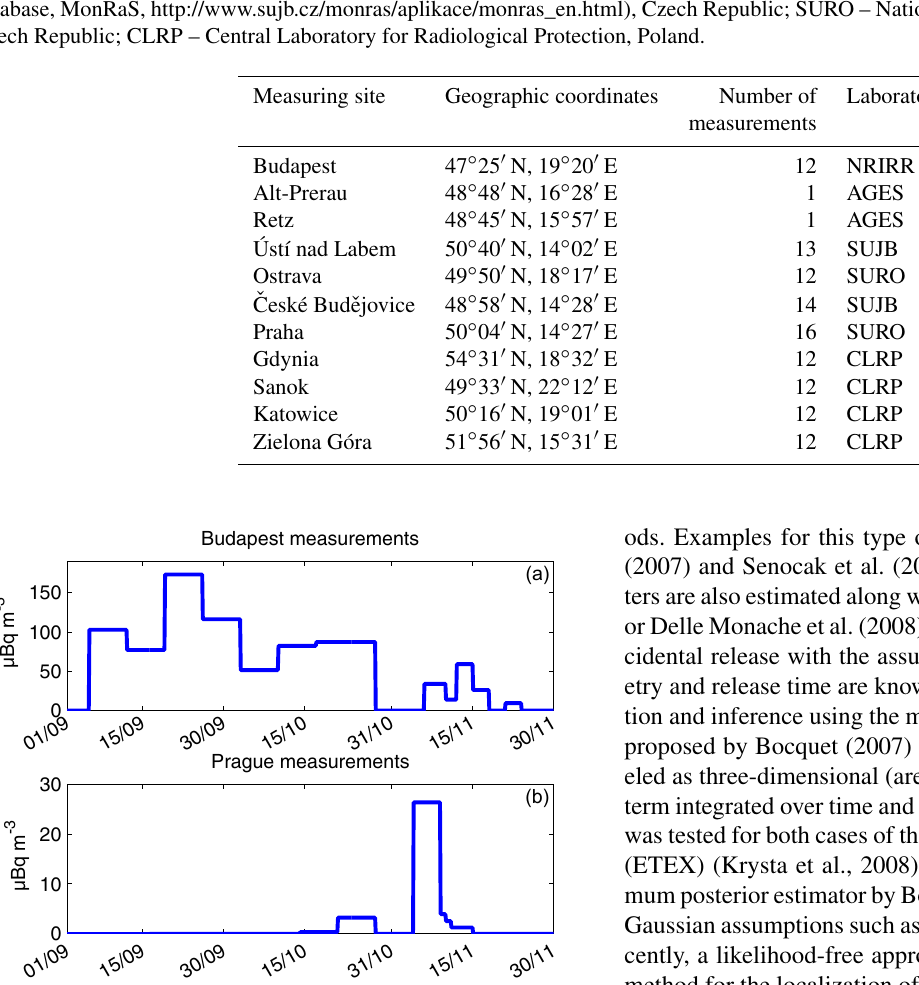
Figure 1. Measurements of 131 I activity concentrations in ambient air made at the stations Budapest (a) and Praha (b) displayed via their daily mean